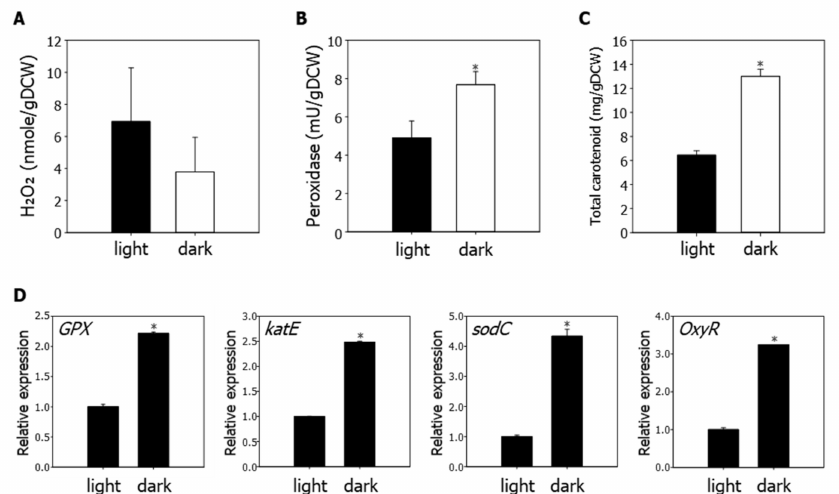
Figure 5. Regulation of endogenous reactive oxygen species in R. sphaeroides . Samples were harvested at 48 h after inoculation. ( A ) The endogenous levels of hydrogen peroxide (H 2 O 2 ) under light or dark aerobic conditions. ( B ) Measurement of peroxidase activity. ( C ) Measurement of total carotenoid contents. ( D ) Expression of reactive oxygen species (ROS)-related